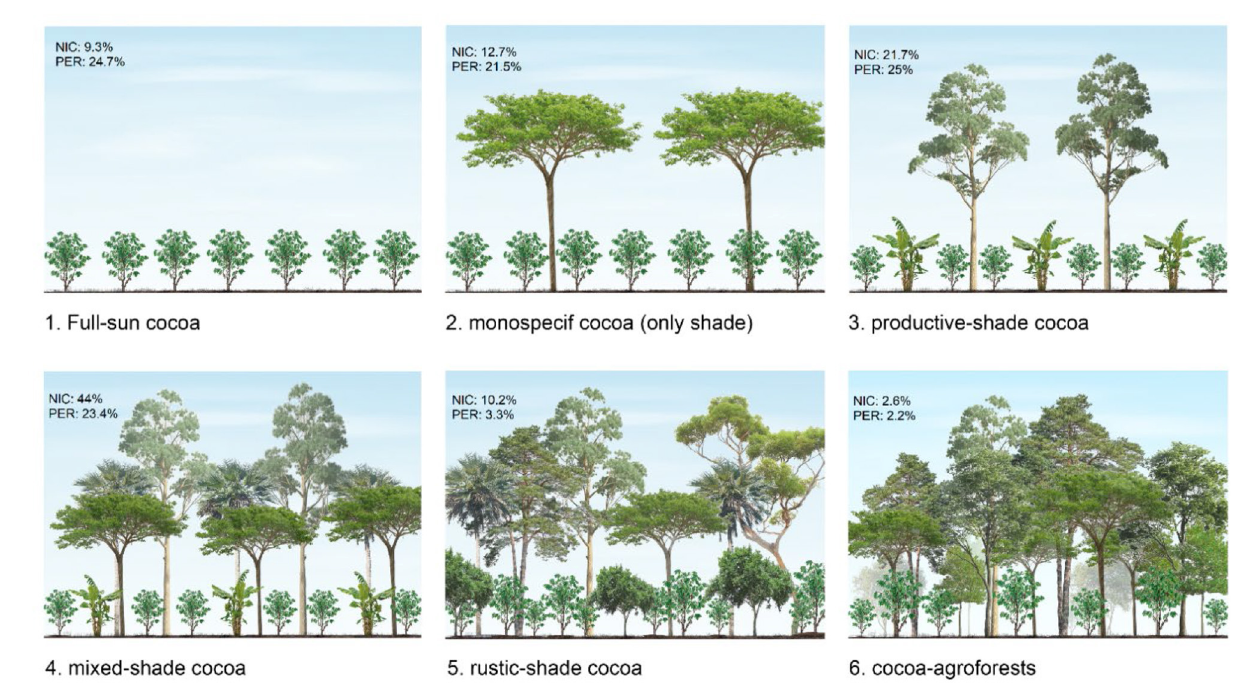
FIGURE 1 | Proportion of shaded cocoa typologies in Nicaragua (NIC) and Peru (PER) as expressed by in-country experts (see Somarriba and Lachenaud, 2013 for an in-depth description of the cocoa